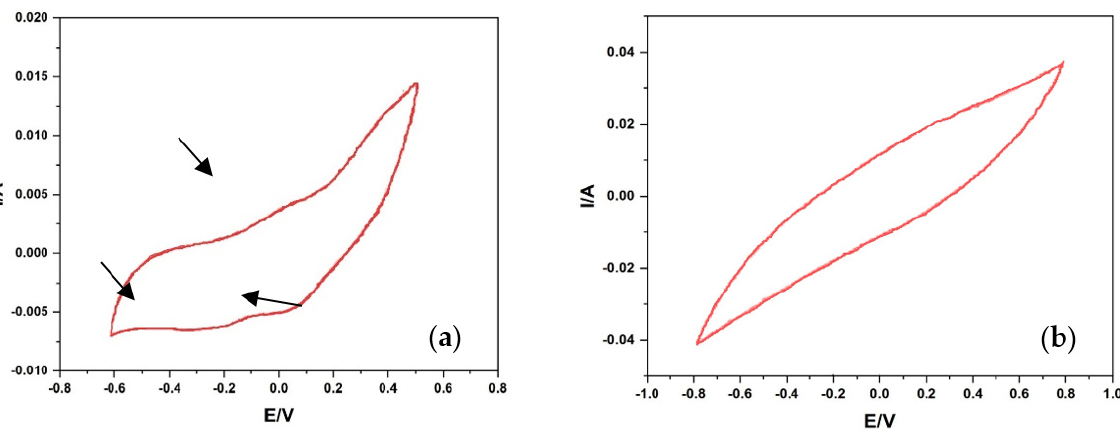
Figure 10. CV (Ag/AgCl) reference of cathode ( a ) and anode ( b ) of a MFC fed with organic residues and in which P. aeruginosa was present at the cathode [11]. Reduction peaks at − 0.280 V and +0.070 V and an oxidation peak at +0.120 V at pH 7.0 ±